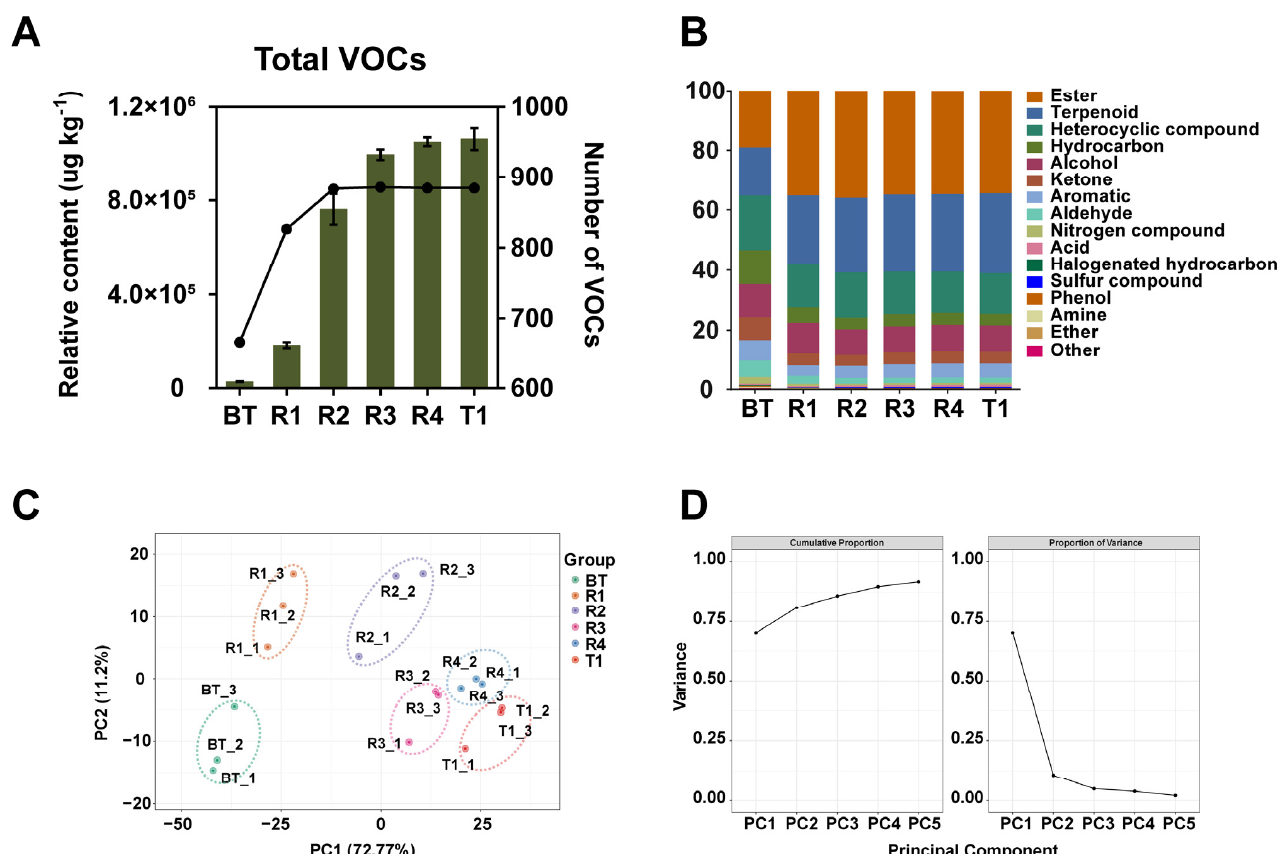
Figure 3. Overview of the profiling of volatile organic compounds (VOCs) in base tea and tea with different rounds of scenting. ( A ) Dynamic changes of the relative content and number of total VOCs in base tea and tea with different rounds of scenting. The column and line represent the relative content and number of VOCs, respectively. ( B ) Classification of the identified VOCs in samples of base tea and tea with different rounds of the scenting process based on their chemical structures and relative contents. ( C ) The principal component analysis (PCA) score plot of samples of base tea and tea with different rounds of the scenting process. ( D ) The cumulative proportion and proportion of variance for the top five principal components from the PCA model. BT: base tea; R1, R2, R3, R4: jasmine tea with one (R1), two (R2), three (R3), and four (R4) rounds of scenting processes; T1: jasmine tea with four rounds of scenting processes and the Tihua process.